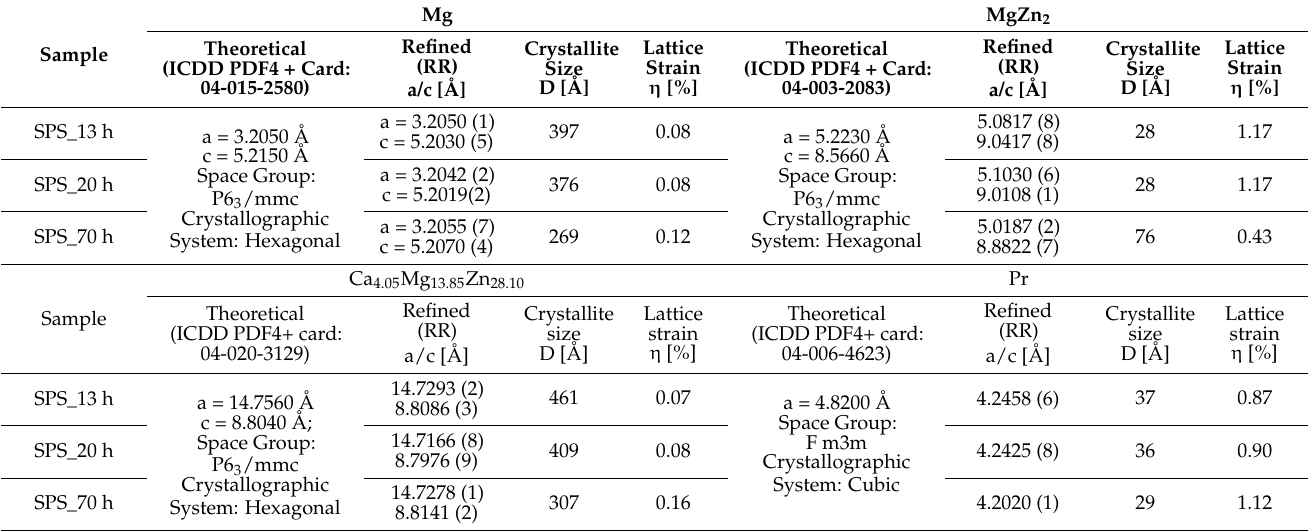
Table 1. Crystallite sizes and changes of unit cell parameters of the main phases present in sintered Mg-Zn-Ca-Pr alloys.